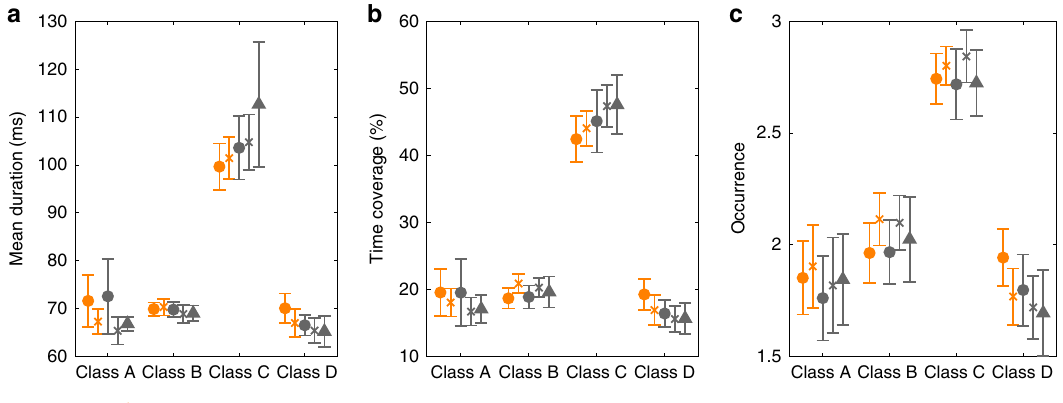
Fig. 3 Results of the re-testing of patients with a fi rst episode of psychosis. Data of patients with a fi rst episode of psychosis that participated in the fi rst and second testing sessions (FEP_2, n = 16) are displayed in orange and data of patients that participated in all three testing sessions (FEP_3, n = 11) are in gray. Group average statistics of the temporal microstate parameters: b mean duration, c time coverage, and d occurrence. For each microstate parameter, we computed a two-way repeated-ANOVA with Testing Session (for FEP_2: fi rst and second; for FEP_3: fi rst, second, and third) and Microstate Class (A, B, C, and D) as factors. No statistically signi fi cant testing session differences and no statistically signi fi cant Testing Session × Microstate Class interaction effects were found for any of the computed microstates parameters. Circles indicate the mean values in the fi rst testing session, crosses indicate the mean values in the second testing session, and triangles the mean values in the third testing session. Error bars indicate s.e.m. Group average statistics are also shown in Supplementary Table 11. Source data are provided as a Source Data fi Summary statistics of the computed microstates parameters for